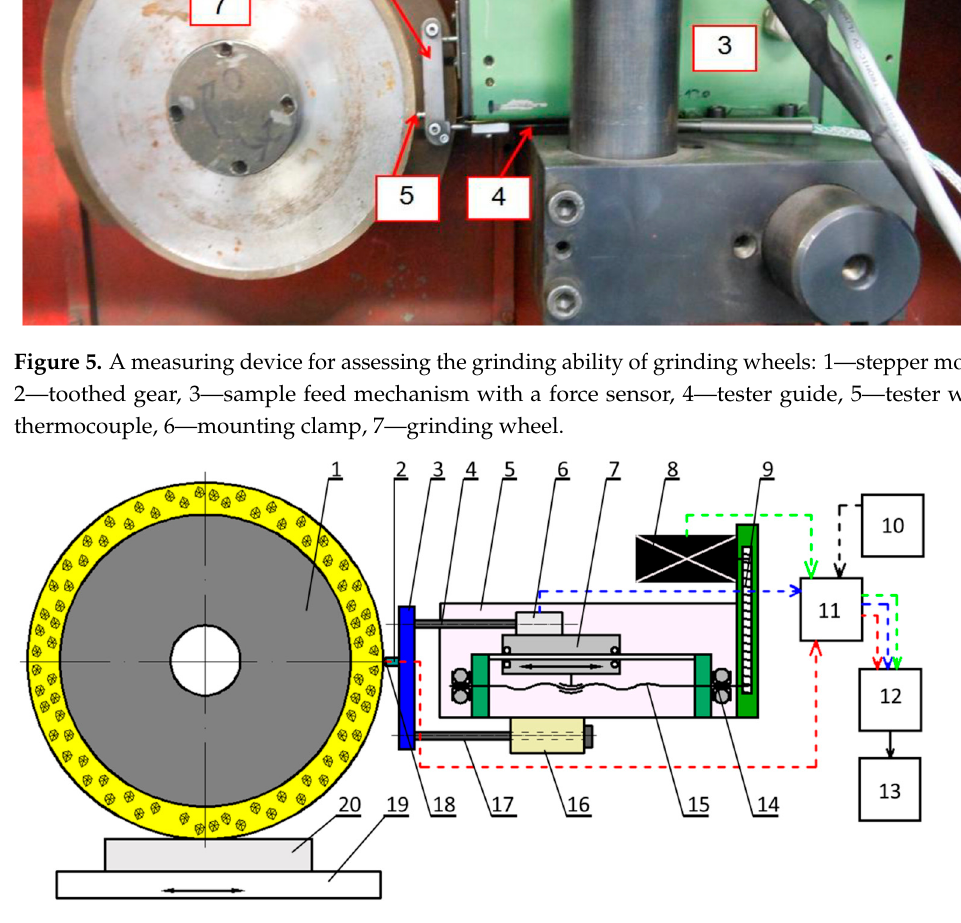
Figure 6. Scheme of the apparatus for assessing the cutting ability of grinding wheels: 1—grinding wheel, 2—tester (titanium alloy sample with thermocouple), 3—mounting bracket, 4—guide, 5—device body, 6—force gauge, 7—slide, 8—stepper motor, 9—toothed gear, 10—power supply, 11—apparatus controller, 12—PC card, 13—computer, 14—bearing, 15—helical-ball gear, 16—auxiliary clamp, 17—guide rail, 18—sheathed thermocouple, 19—grinder table, 20—workpiece. The tester—2 (Ti-6Al-4V titanium alloy sample—5 mm in diameter with a K -type